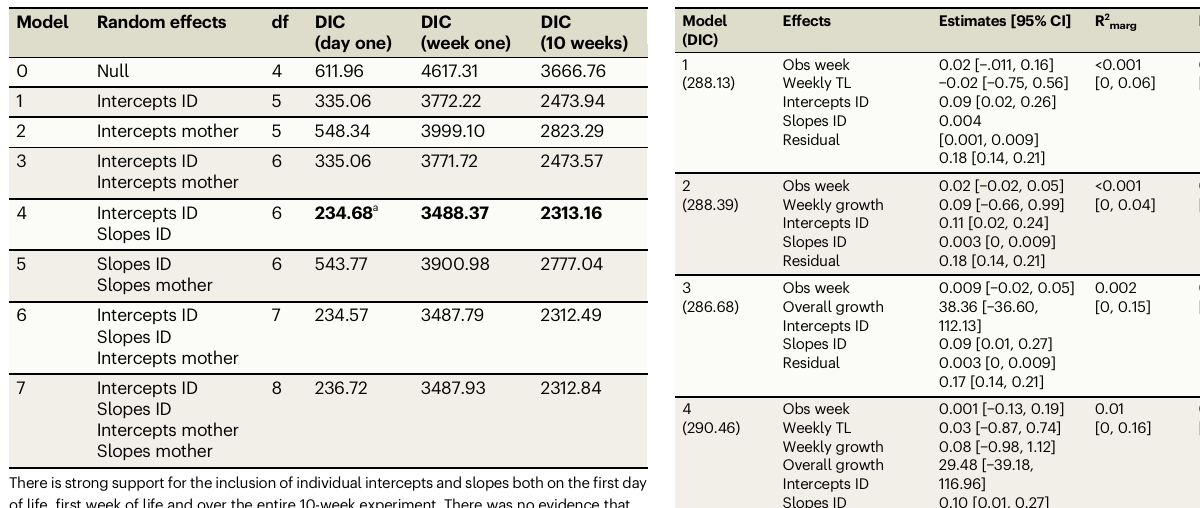
Table 2 | Morphological and physiological differences do not explain individuality